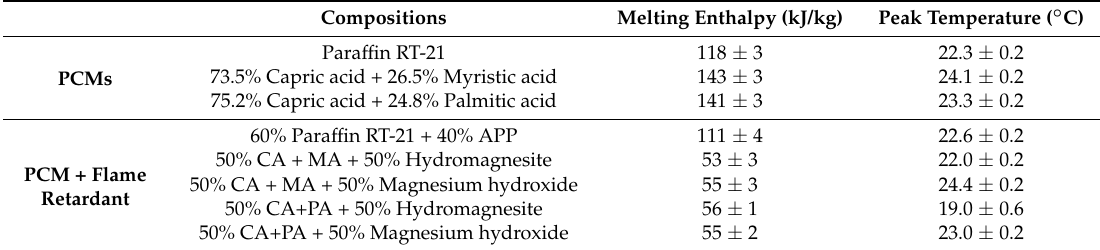
Table 5. DSC of PCM-fire retardant optimum combination results.